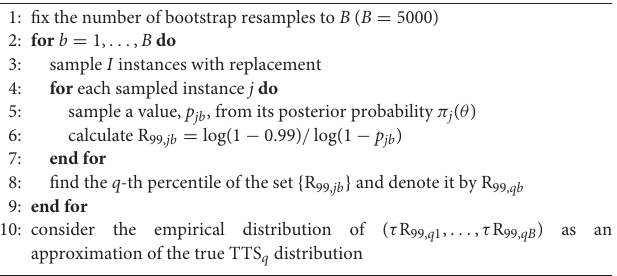
Algorithm 4 Estimating the Distribution of the q -th Percentile of the